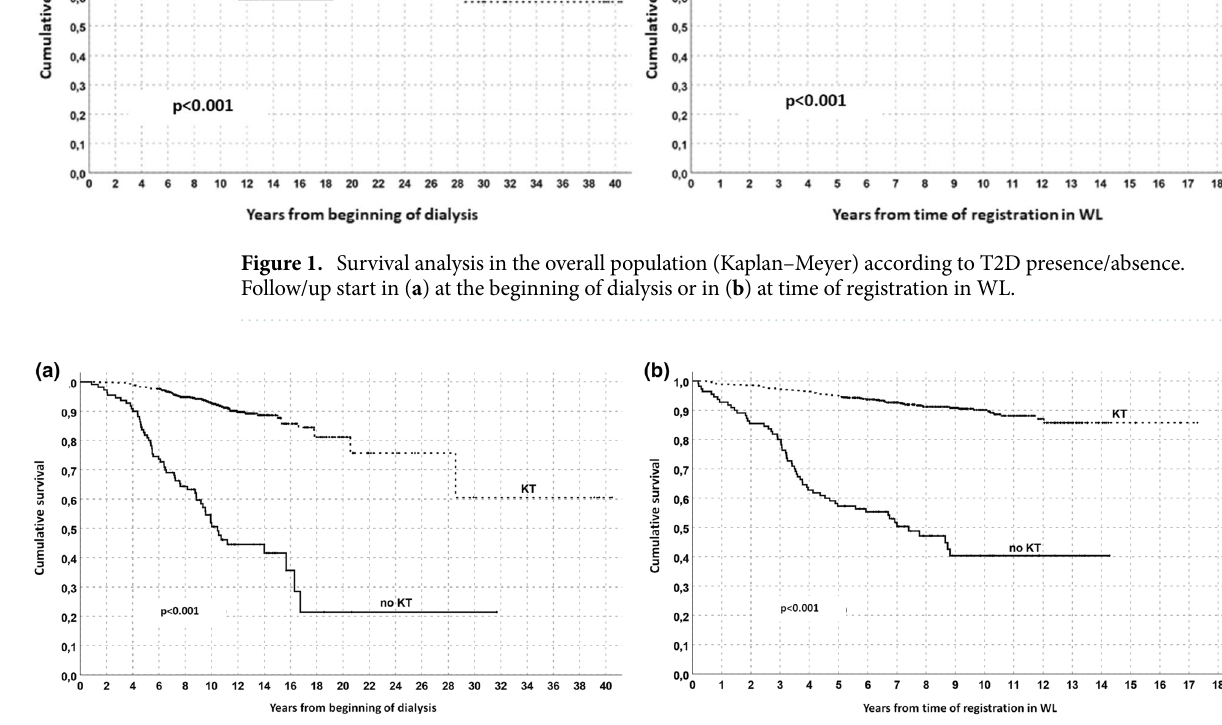
Figure 2. Survival analysis in the overall population (Kaplan–Meyer) according to kidney transplantation or maintenance on WL. Follow/up start in ( a ) at the beginning of dialysis or in ( b ) at time of registration in (25° 55–75° 64)]. Considering vascular disease, percutaneous coronary intervention (PCI) and coronary artery bypass grafting (CABG) were performed in 13/86 (15.1%) and 4/86 (4.7%) respectively; an history of cerebro- vascular accident was also observed in 9/86 T2D patients (10.5%). During the follow-up (mean 8.4 ± 3 years) 604 patients underwent KT (84.6%) with a significantly lower KT rate in T2D group (75.6% vs 85.8%, p = 0.013). The number of living donors was similar in each group but, in deceased donors, donor’s age was higher in T2D group.